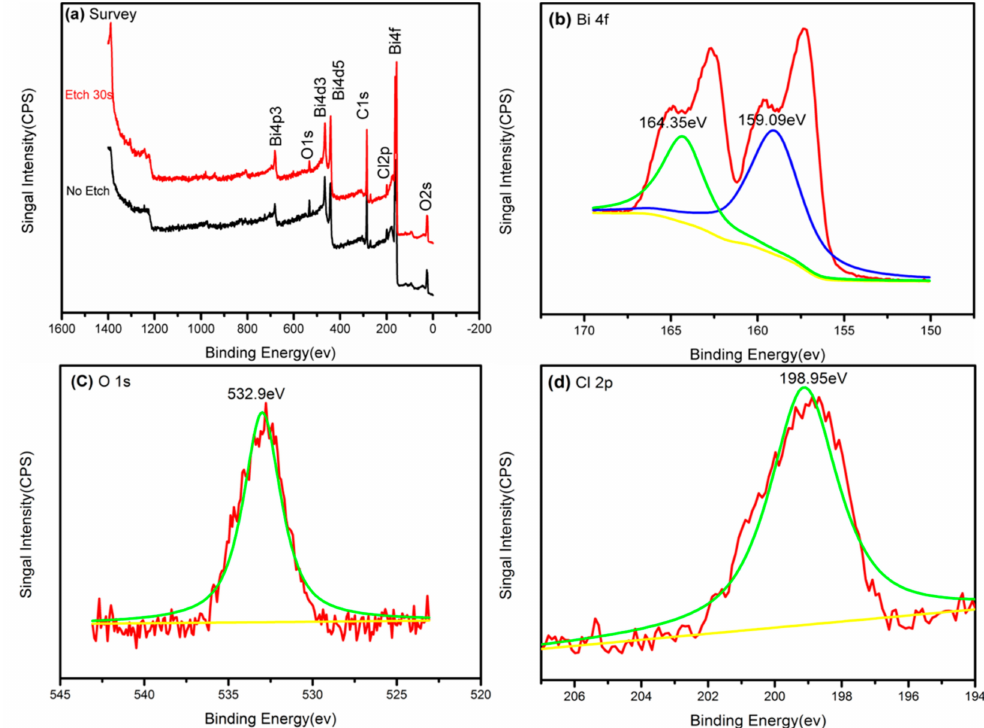
Figure 3. XPS spectra of 2% Dy doped BiOCl ( a ) and the corresponding high-resolution XPS spectra of Bi ( b ); O ( c ); Cl ( d